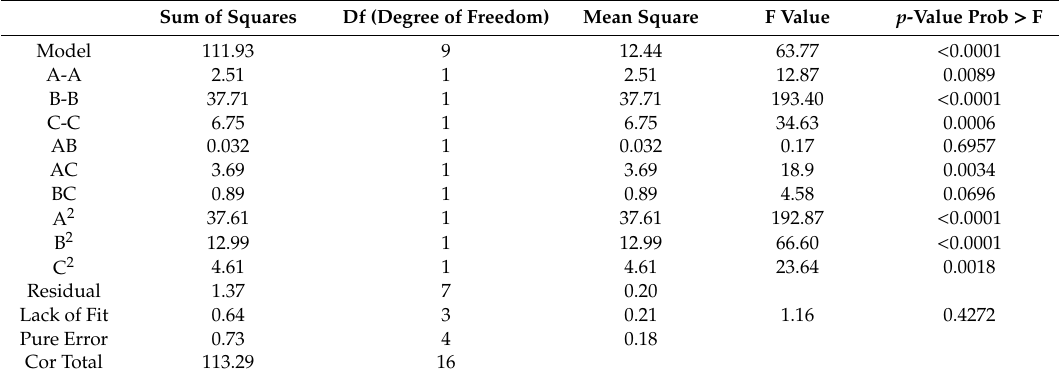
Table 2. Analysis of variance and significance